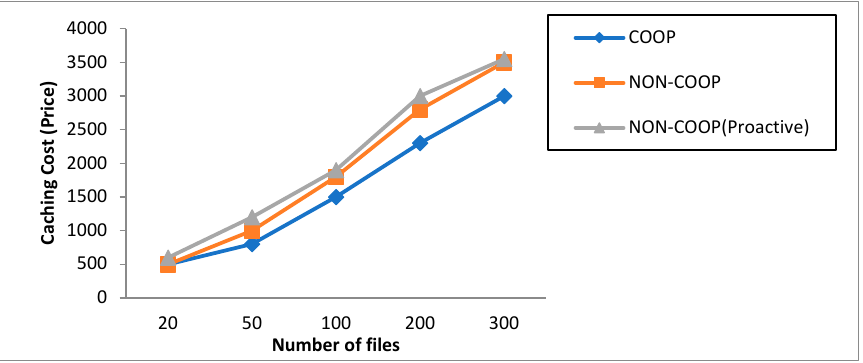
Figure 12. Caching cost with increasing number of files.